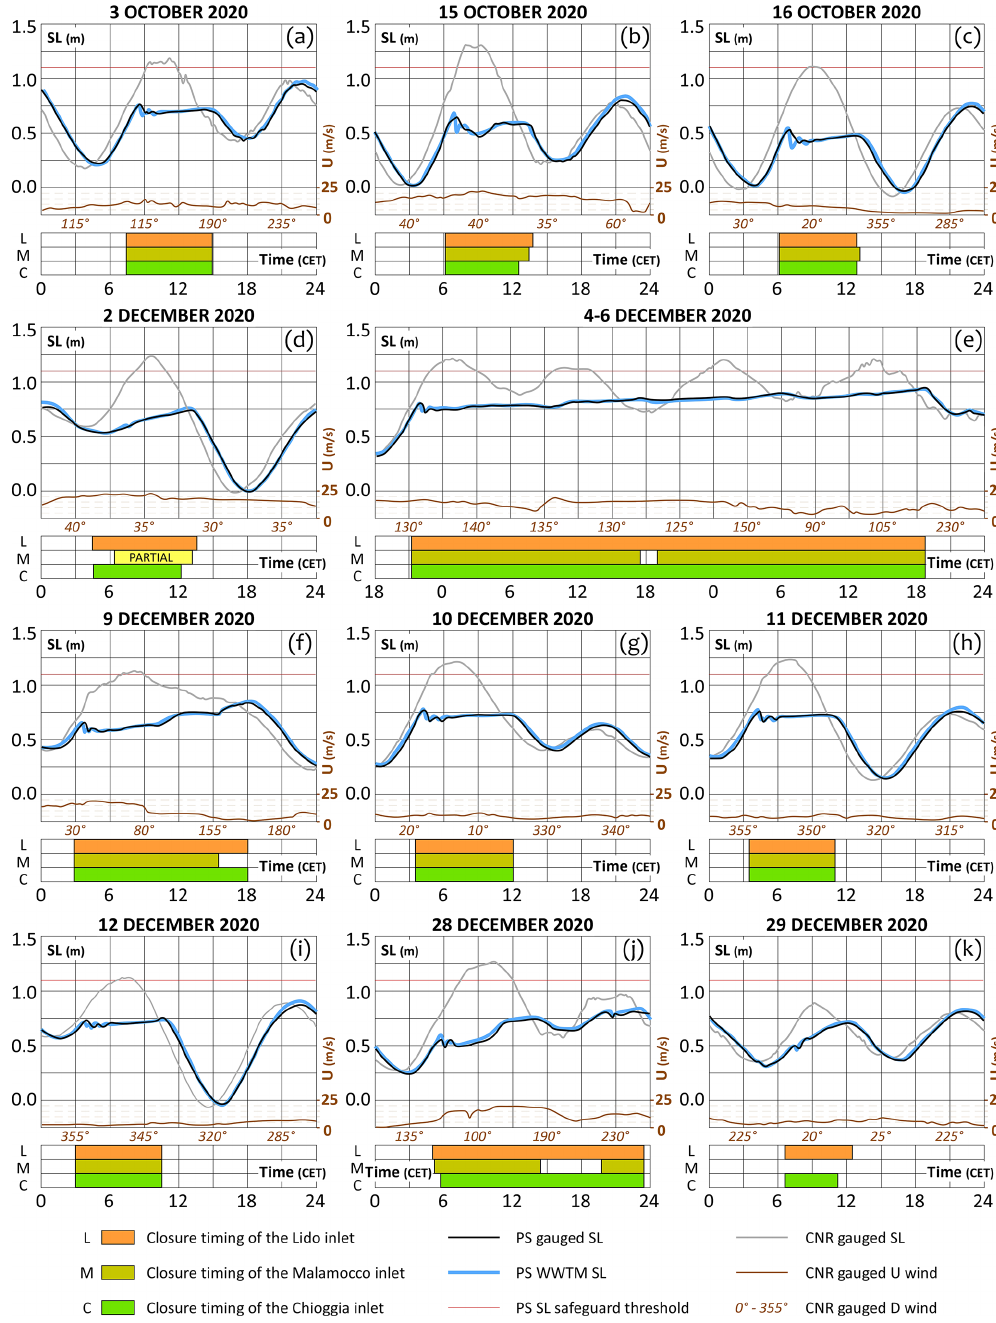
Figure A1. Events when the Mo.S.E. barriers have been raised in testing phase. Comparison between SLs observed at the CPSM gauge of PS (black lines) and computed by the WWTM model forcing the closure of the Mo.S.E. barriers (blue lines). Grey and brown lines represent, respectively, the SLs and the wind speeds observed at the CPSM gauge of the CNR platform. The red line represents the safeguard threshold at PS (1.10m). Bars indicate the periods when the barriers of Lido (orange), Malamocco (yellow), and Chioggia (green) were temporarily closed in the respective